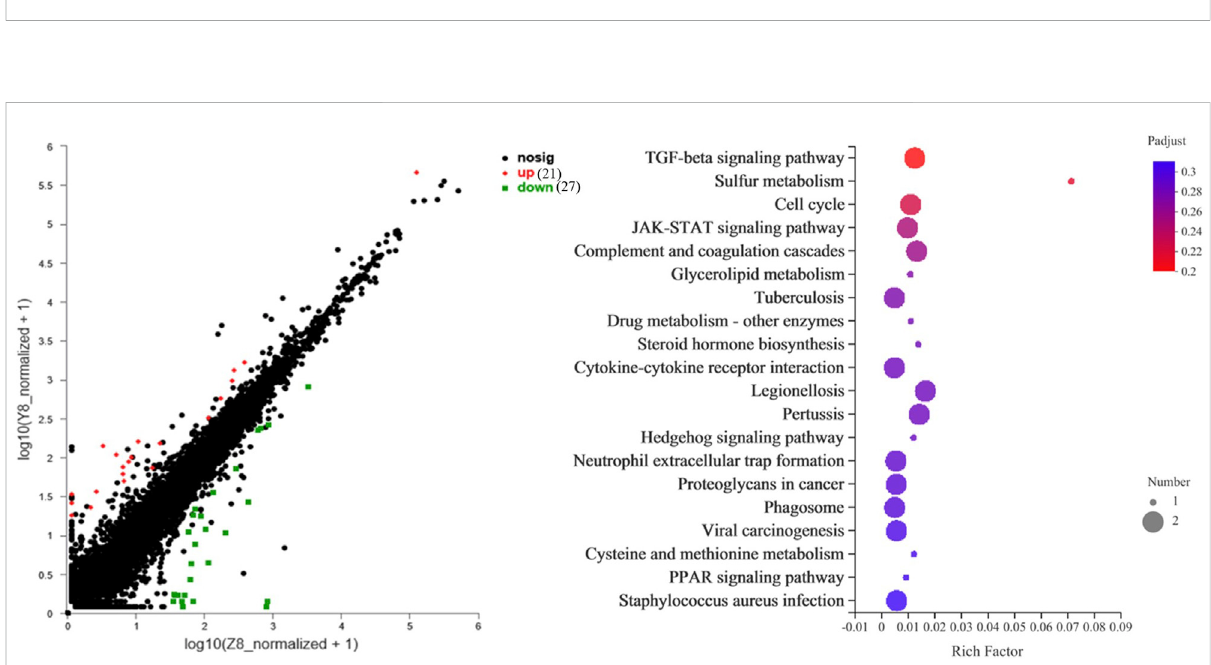
FIGURE 5 KEGG and Venn pathway analysis of the transcriptome data. Left: KEGG pathway analysis of the common genes obtained according to Venn analysis. The rich factor represents the enrichment degree, and the dot size represents the number of genes in the corresponding pathway. Right: Venn analysis of the differential genes between groups W6 and W12 (blue), and between groups Y6 and Y12 (red).